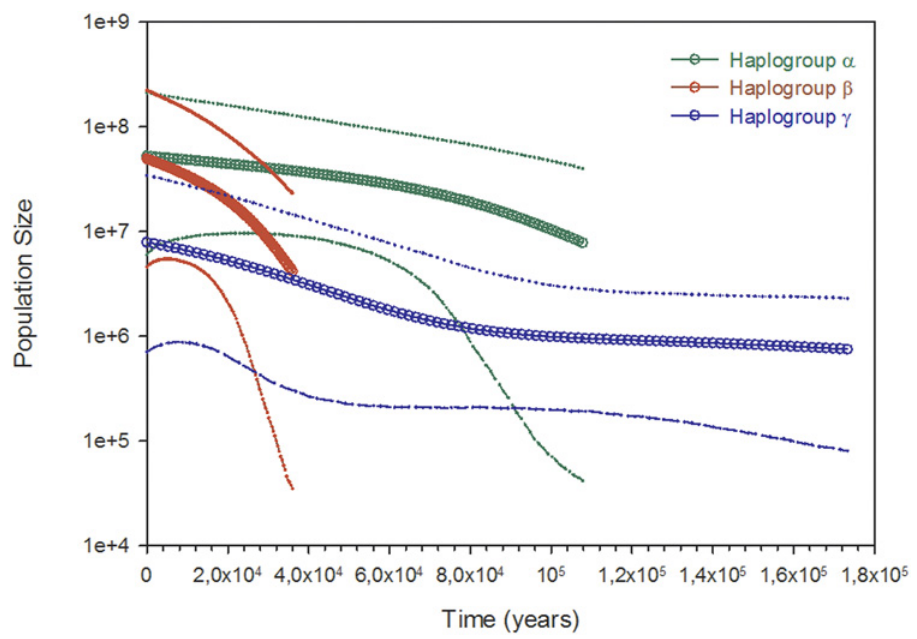
Fig 7. Bayesian skyline plot for Megabalanus azoricus haplogroups. Bayesian skyline plot based on mitochondrial control region coalescent analysis for the Megabalanus azoricus